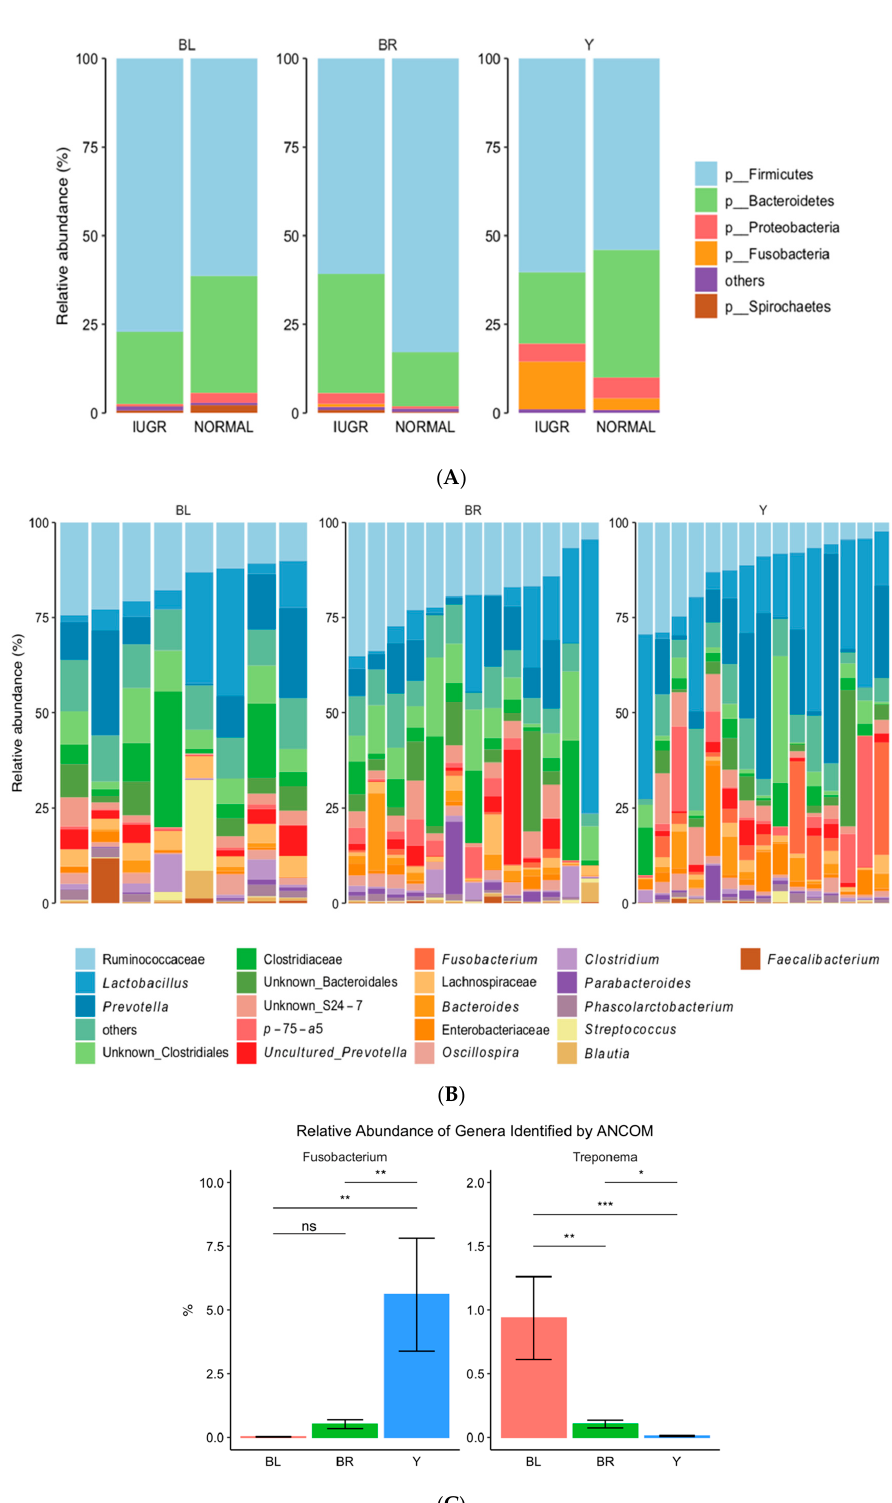
Figure 6. ( A ) Phyla distribution present in yellow (Y), brown (BR), and black (BL) fecal samples (intrauterine growth-restricted (IUGR) and normal); ( B ) distribution of genera across yellow, brown, and black fecal samples; ( C ) overview of the relative abundance of genera present in yellow, brown, and black colon content, as determined by 16S rRNA gene V3-region amplicon sequencing. * indicates a significance at p < 0.05, ** indicates a significance at p < 0.01 and *** indicates a significance at p <